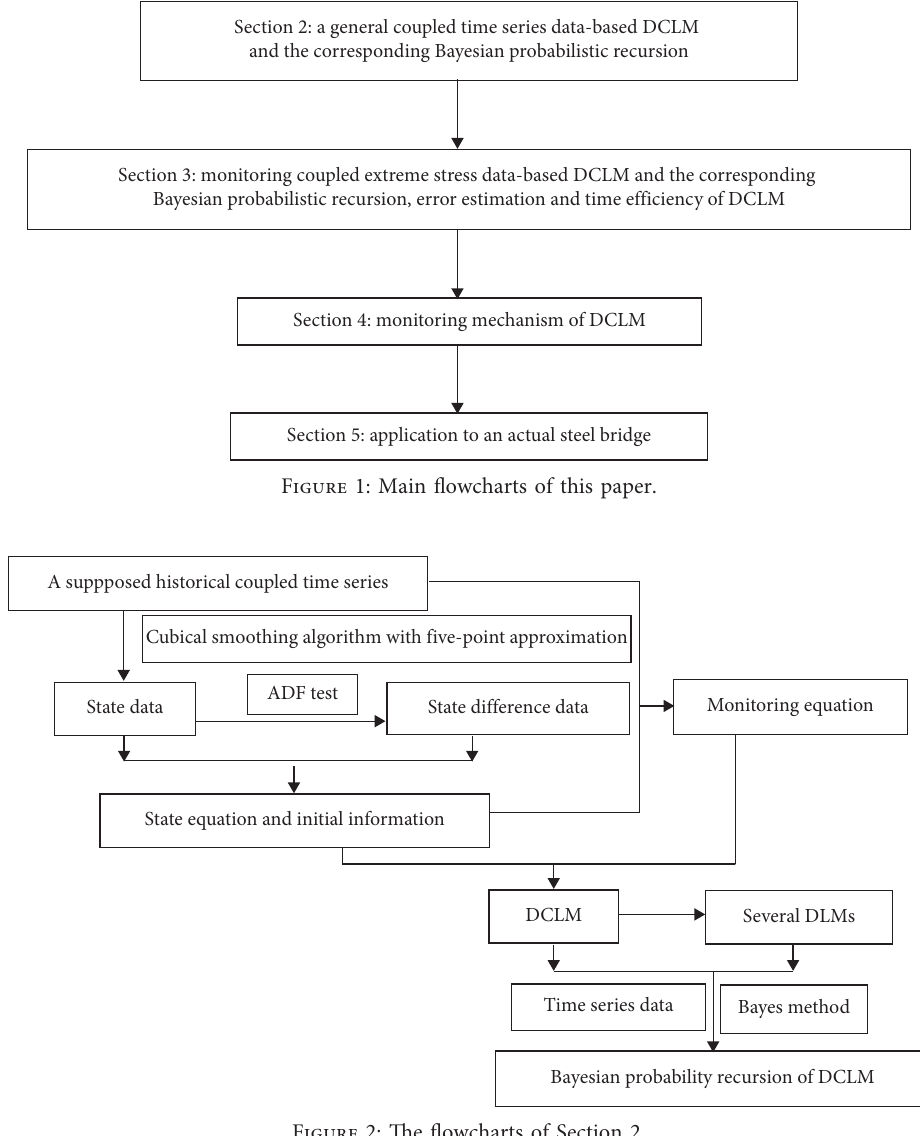
Figure 2: The flowcharts of Section